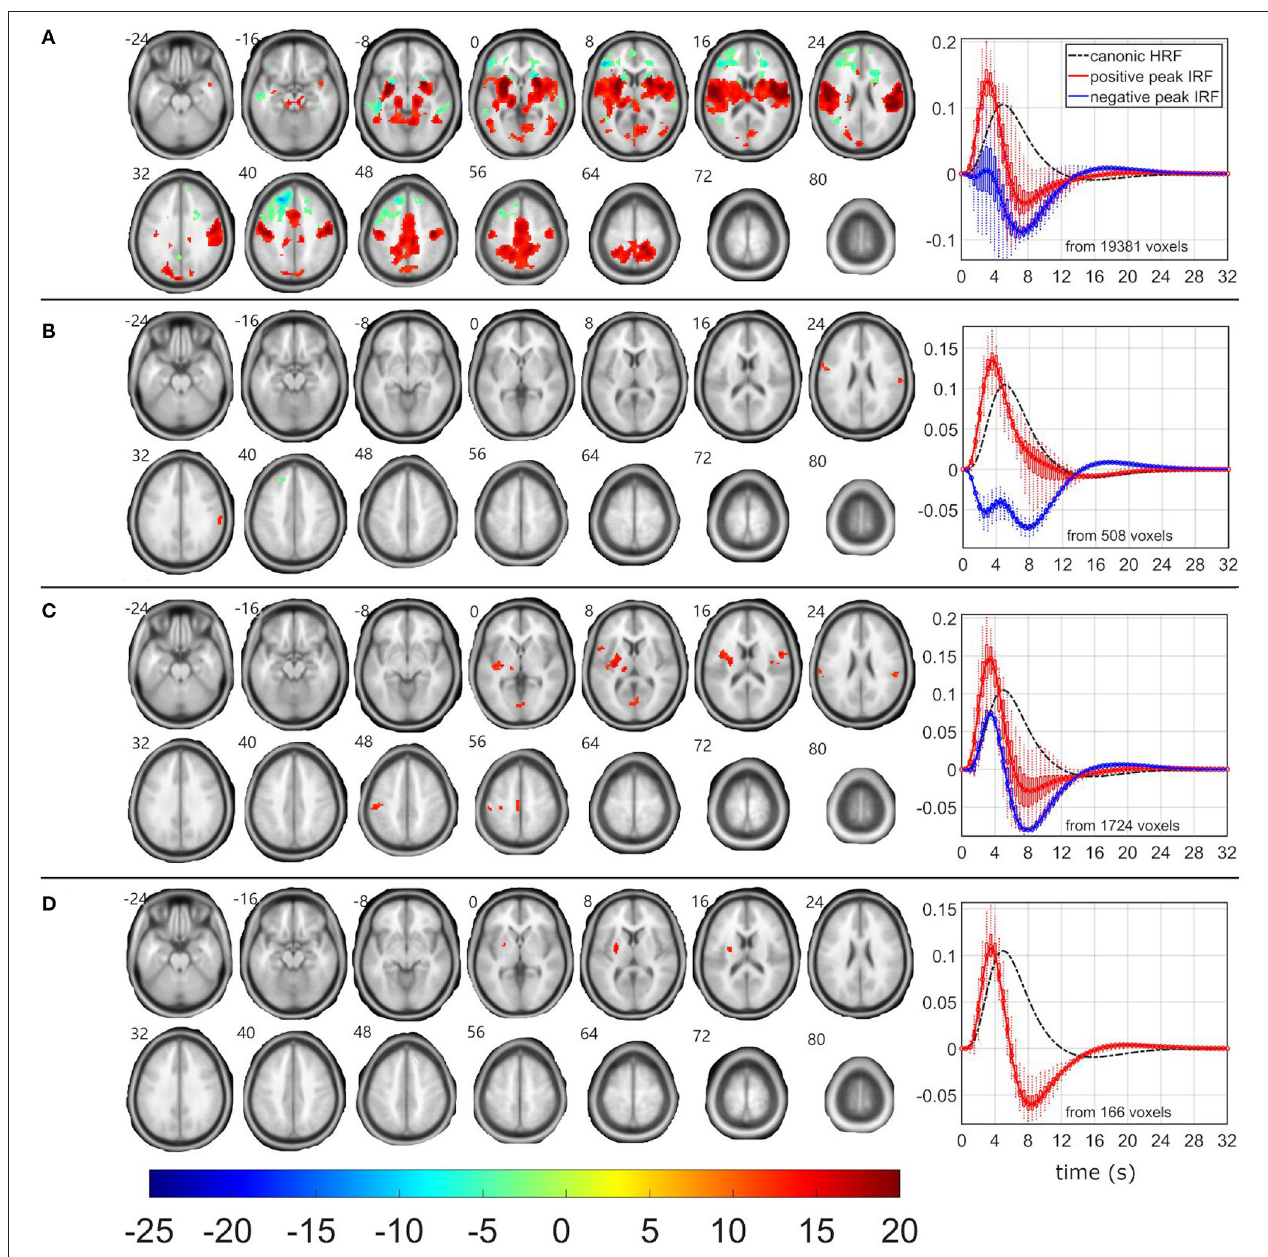
FIGURE 5 | EEG-fMRI F-maps and estimated hemodynamic response functions for all investigated models of the δ 2 pattern. The EEG-fMRI F-map colorbar is the same over all models. HRF, hemodynamic response function; IRF, impulse response function. If HRF demonstrated a reduced peak and an amplified trough (i.e., blue color-coded HRFs) the F -values were assigned with a negative sign. The F-maps were threholded with p < 0.0001, i.e., |F| > 8.1. The voxels with |F| > 12.1 met the condition p FWE < 0.05. The red color coded HRFs were derived from voxels with positive signed suprathreshold F -values. All F-maps are shown following the neurological convention, i.e., left hemisphere on the left side of the axial slice. (A) Absolute spectral. (B) Relative spectral. (C) Absolute spatiospectral. (D) Relative